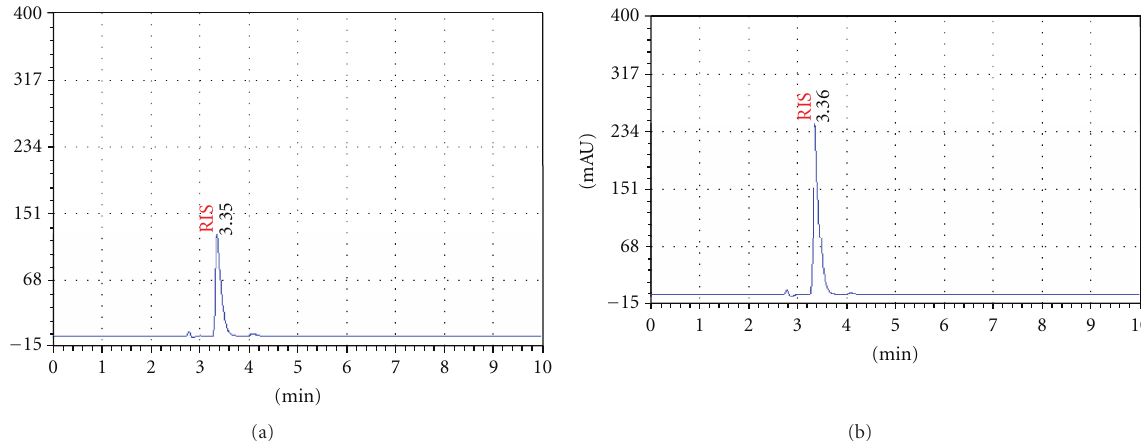
Figure 2: Resultant HPLC chromatograms following the analysis of a standard solution of Risperidone 20 µ g/mL (a) and Risperidone tablets (2mg) (b).